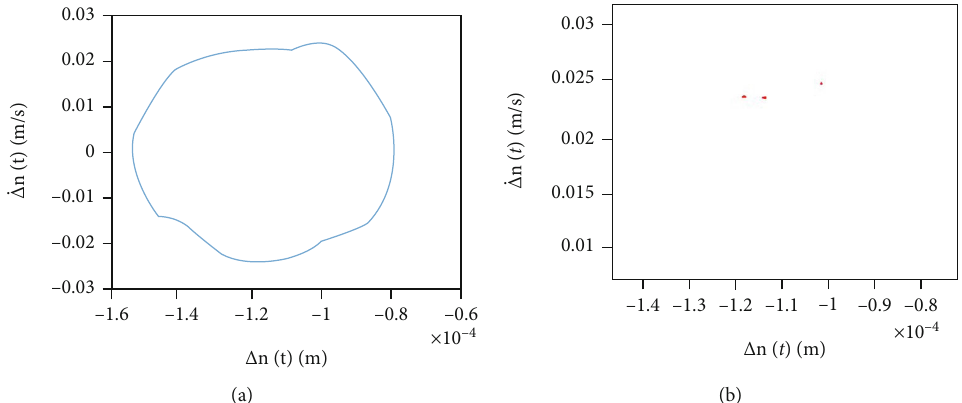
Figure 18: When the wear is 3 : 975 × 10 − 5 m (the misalignment in the x direction is 2 : 8 × 10 − 4 m): (a) relative displacement velocity and (b) the corresponding diagram of Poincare.